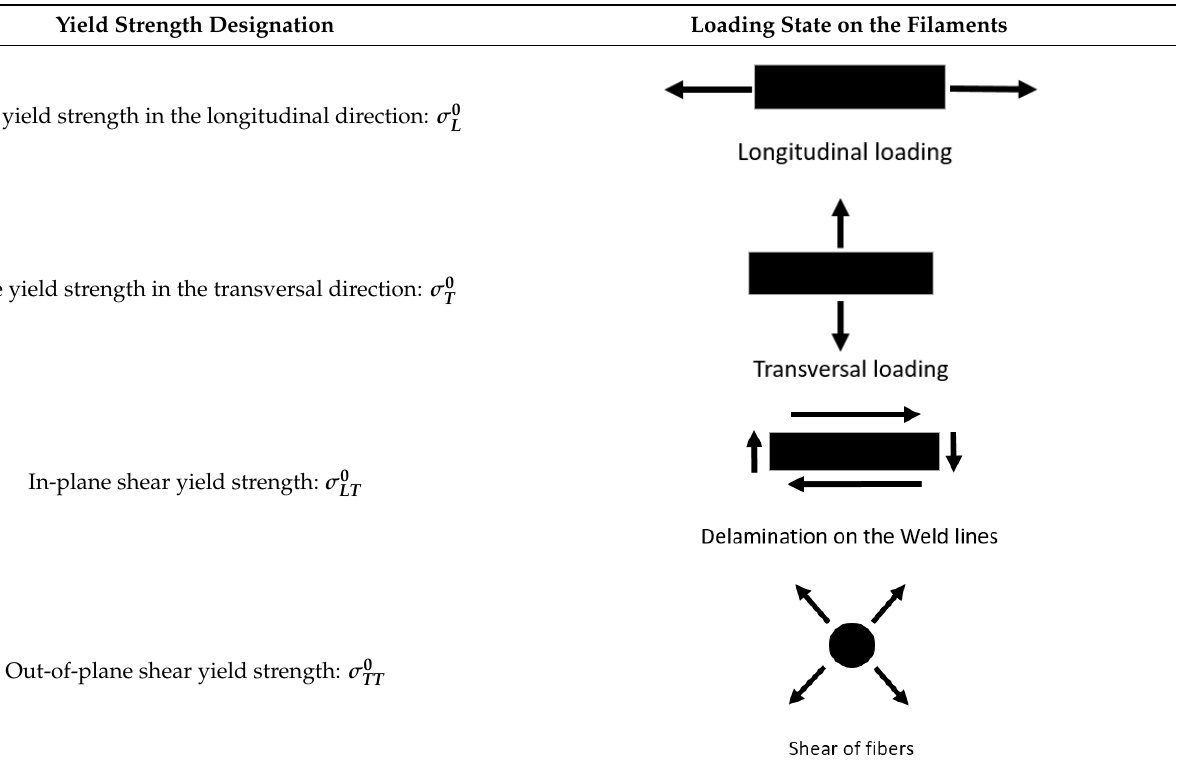
Table 3. Yield strengths designation for the transverse isotropic material.